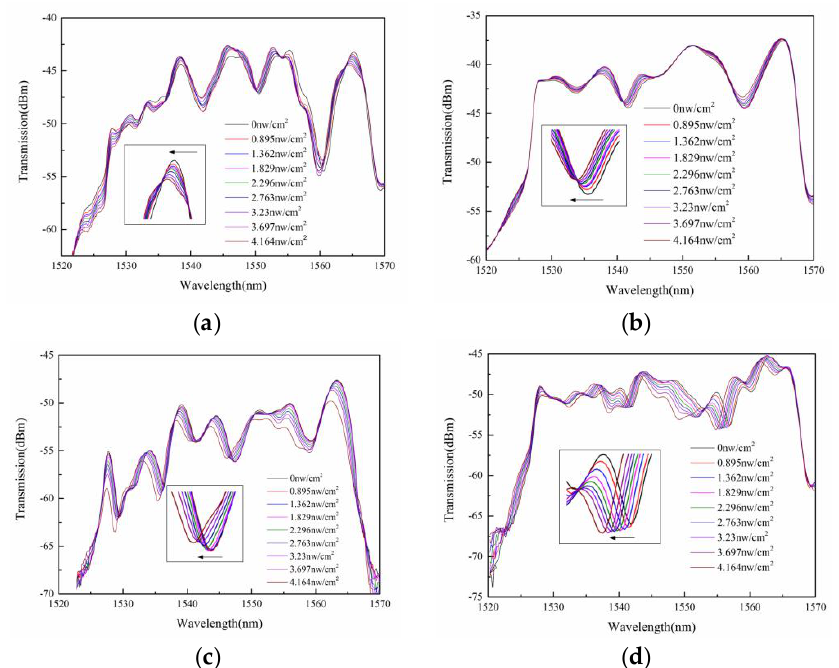
Figure 3. The transmission spectra of single-mode-taper multimode-single-mode (STMS) coated ZnO and ZnO composite graphene: ( a ) ZnO microspheres; ( b ) ZnO nanorods; ( c ) ZnO nanosheets; ( d ) flake ZnO composite graphene.